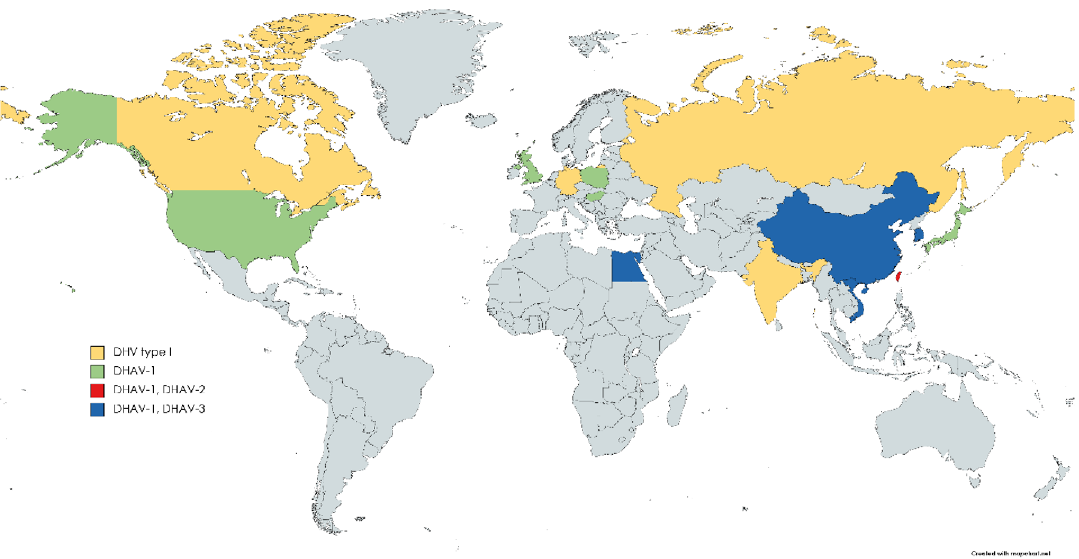
Figure 1. Geographic distribution of DHAV serotypes/genotypes. DHV type I is a historic assignment of DHAV introduced prior to the separation of serotypes.